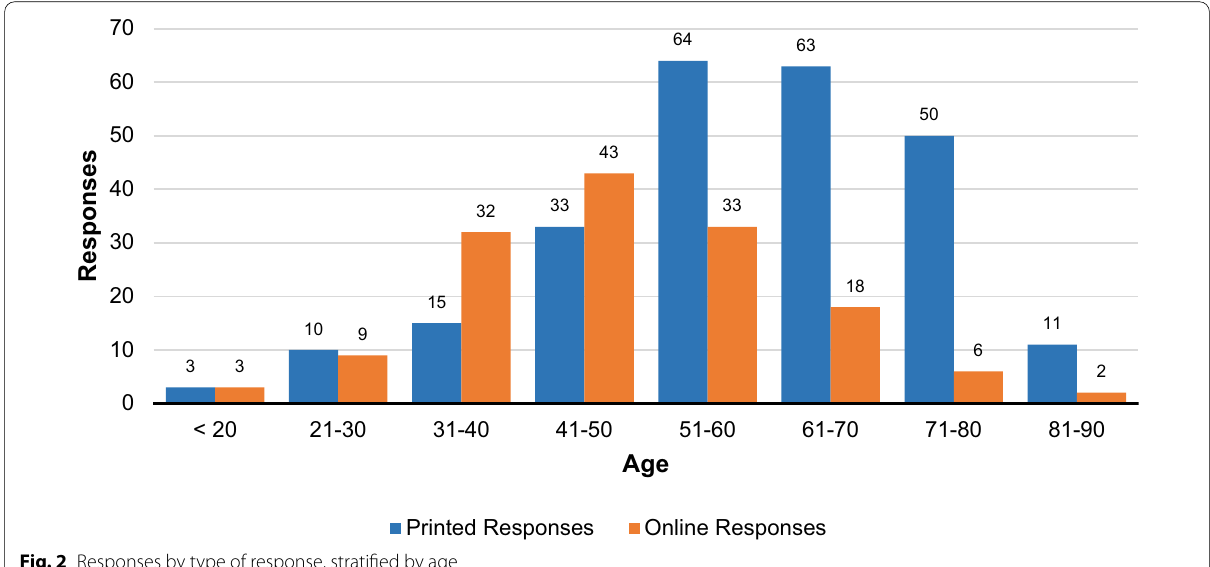
Fig. 2 Responses by type of response, stratified by